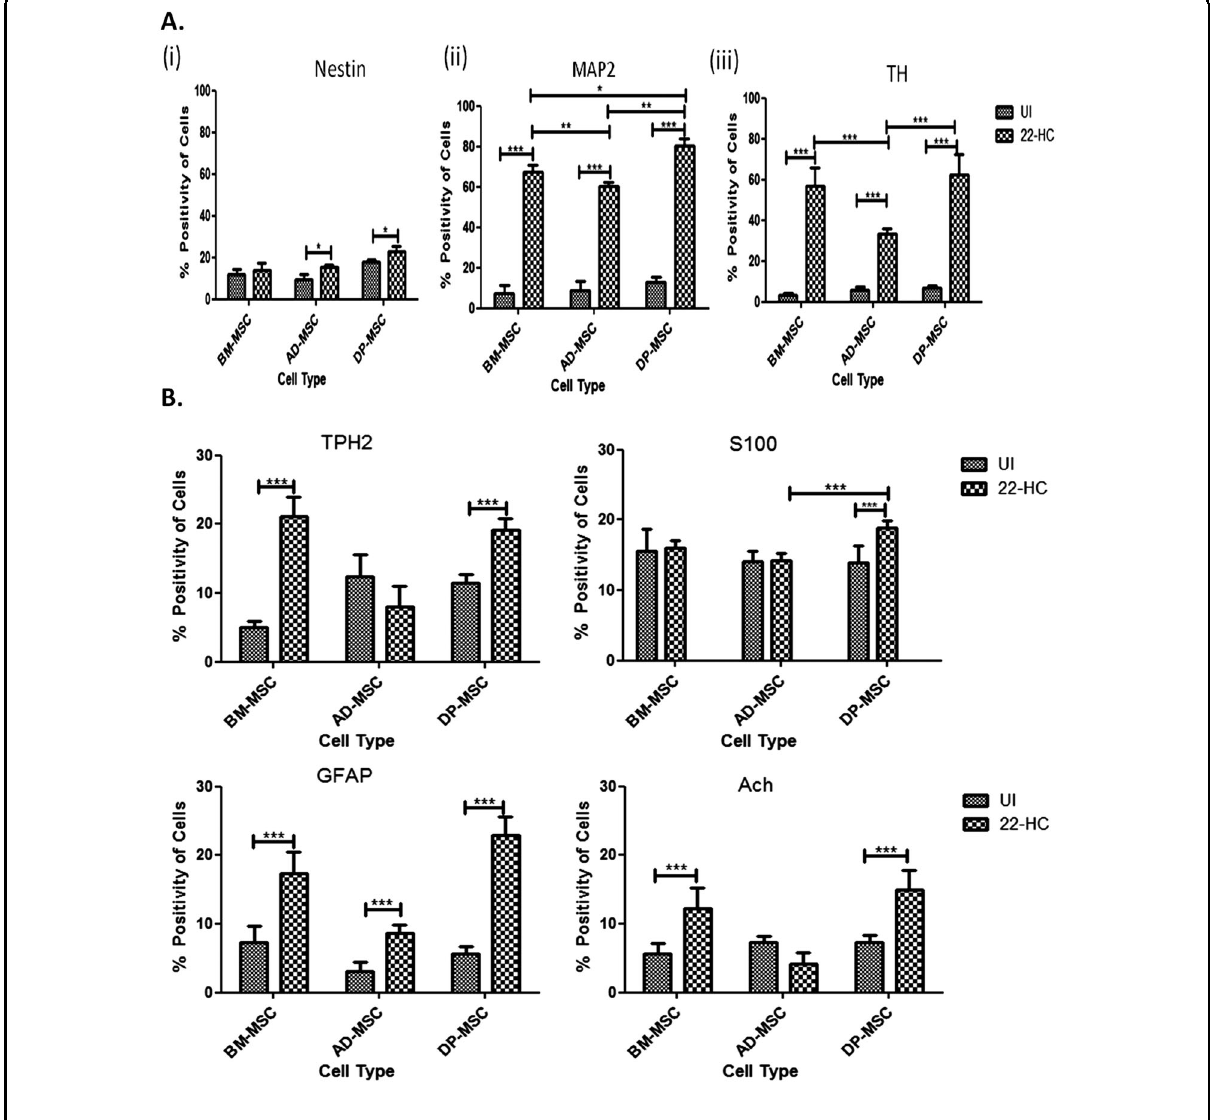
Fig. 4 Flow cytometric analysis for cell enumeration. A (i) Graph depicting the number of nestin-positive cells pre-neuronal and post-neuronal induction. DP-MSC have maximum number of nestin positive (p*), cells at the beginning of experiments, followed by those in AD-MSC and BM-MSC; (ii) graph depicting the number of MAP2-positive cells pre- and post-neuronal induction. (p*); (iii) graph depicting the number of TH-positive cells pre- and post-neuronal induction. Data points represent the means ± SD ( n = 3), * p < 0.001 vs. control untreated cells. B Flow cytometric analysis for cell enumeration of non-DAergic neuronal cells in the cell-milieu, pre-neuronal and post-neuronal differentiation of